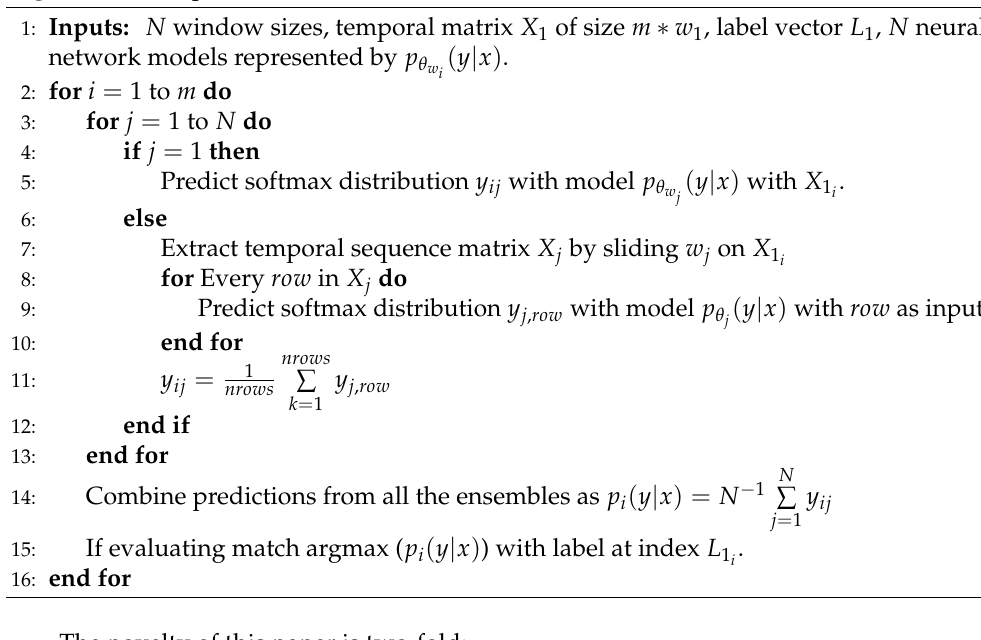
Algorithm 2 Deep Time